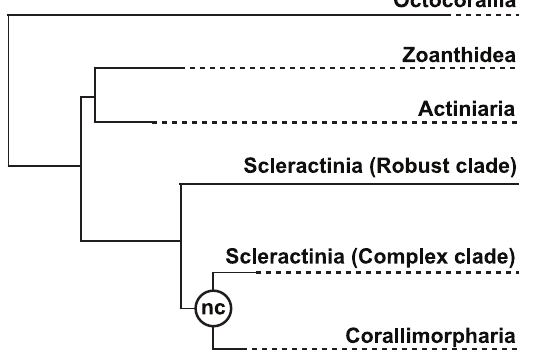
Figure 1. Phylogenetic relationships within the cnidarian Class Anthozoa according to the ‘‘naked corals’’ (nc) hypothesis (modified from [24] ).